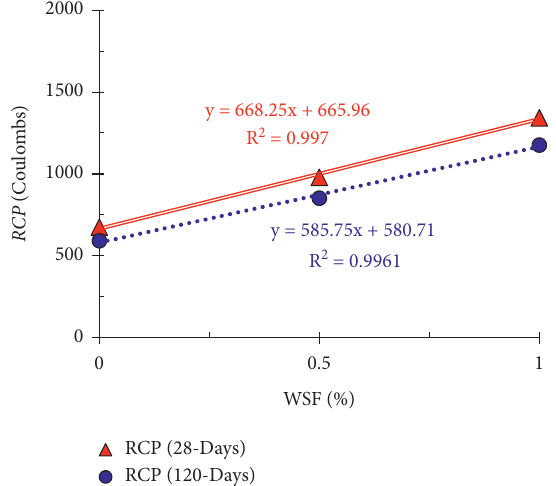
Figure 19: Relationship between WSF content and corresponding RCP values of